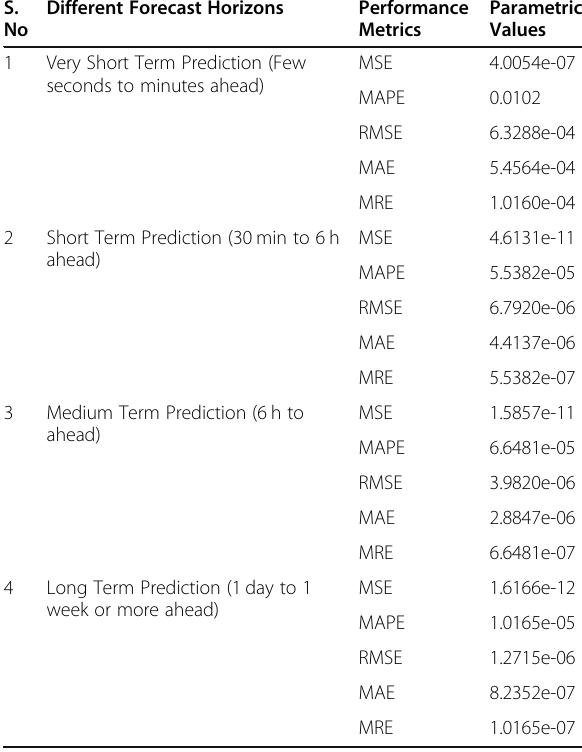
Table 6 Analysis of the proposed prediction model with different forecast horizons S. Different Forecast No